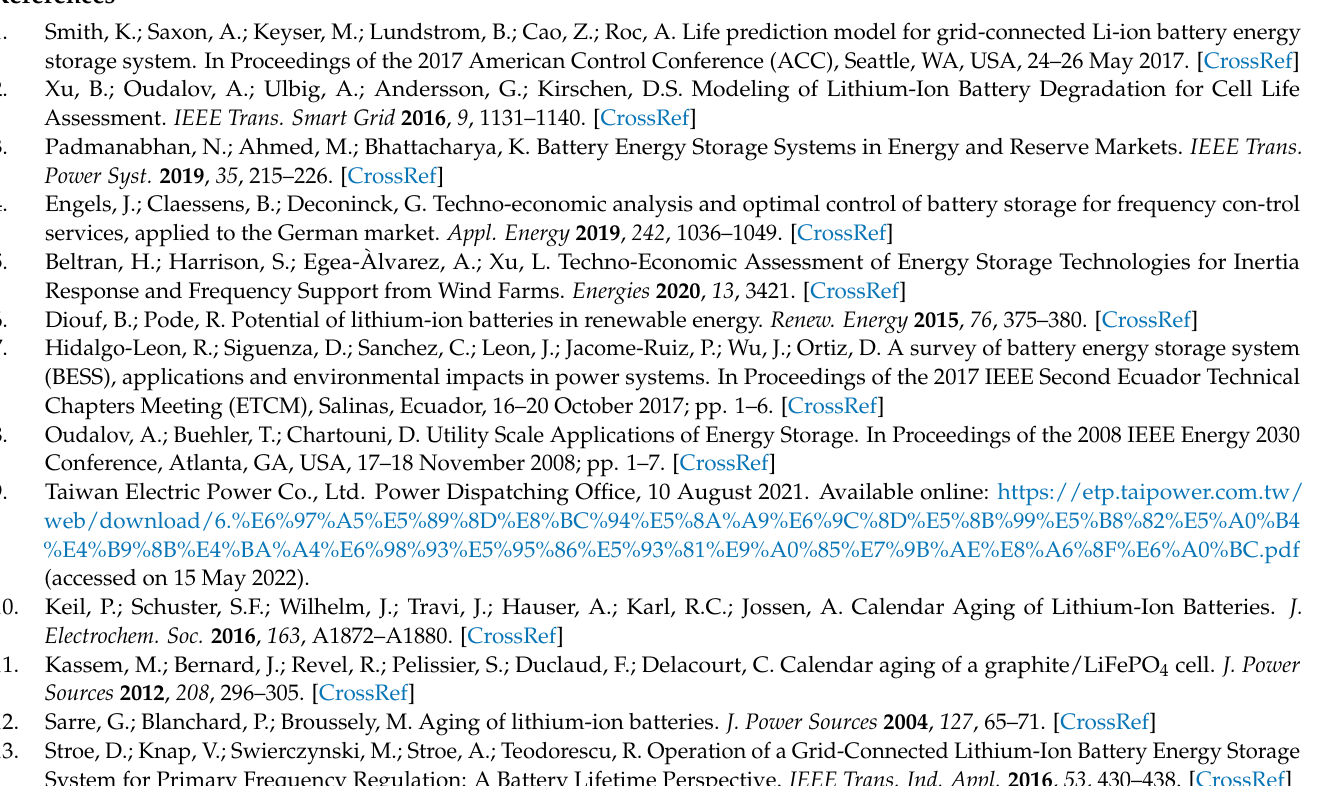
Figure A8. SOC curve and aging features of Scenario 7.